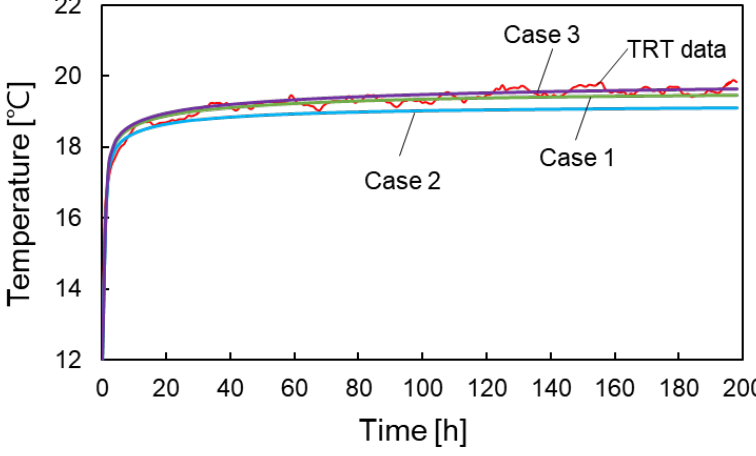
Figure 12. Temperature variation according to the TRT end time.